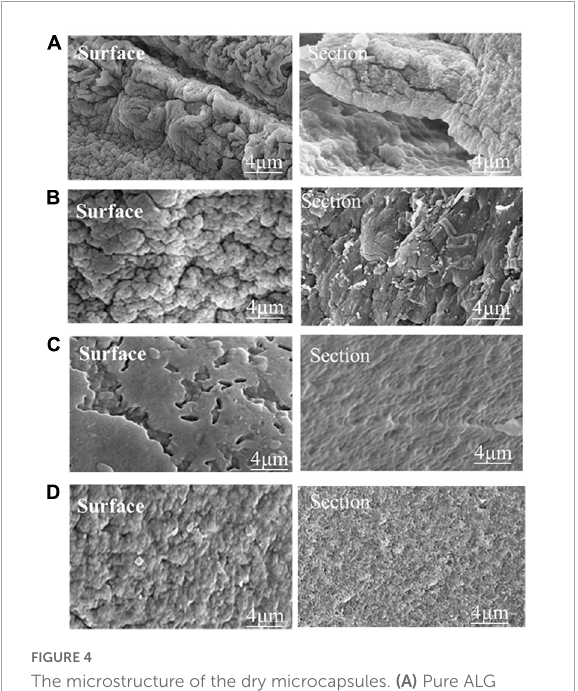
FIGURE4 The microstructure of the dry microcapsules. (A) Pure ALG microcapsule. (B) ALG-phage microcapsule; (C) AC microcapsules; (D) AC-phage